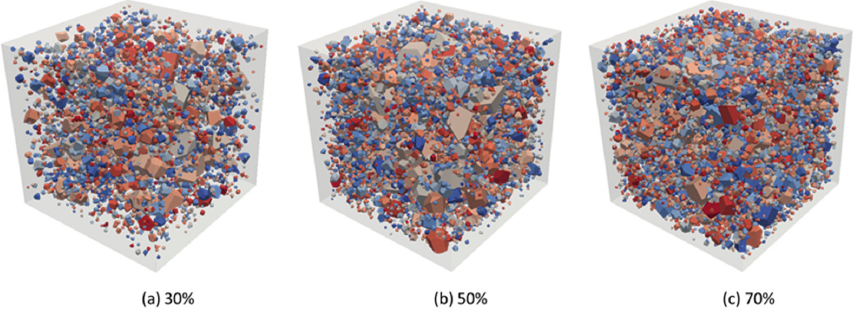
Figure 19. Numerical concrete models by irregular polyhedra, among which the aggregate volume fractions are ( a ) 30%, ( b ) 50%, and ( c ) 70%, respectively.